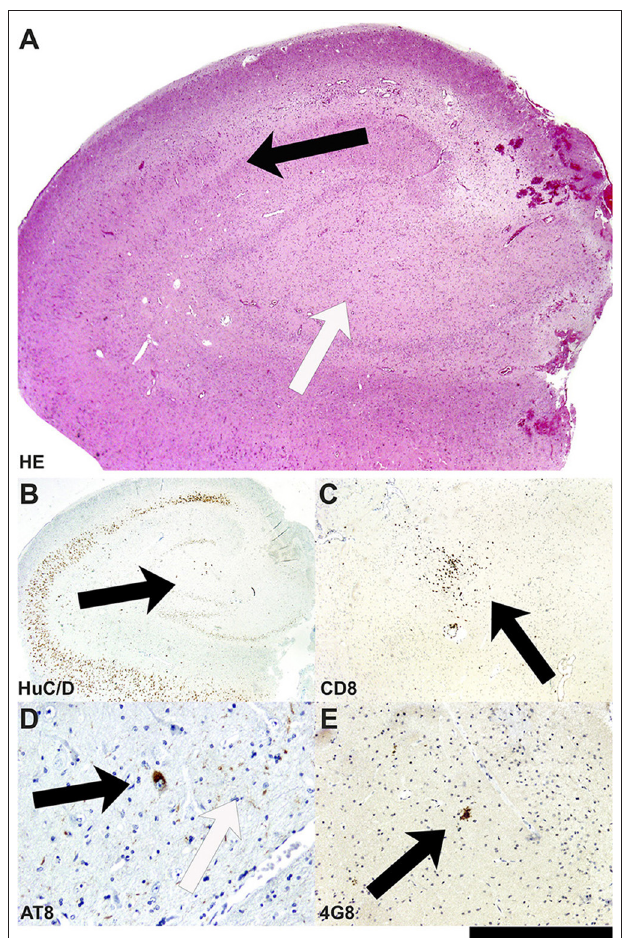
FIGURE 2 | Neuropathological findings in the hippocampal biopsy specimen in Patient #4. (A) On the HE-stained section, the hippocampal formation reveals segmental neuronal cell loss in the hilus/CA4 as well as CA3 area (white arrow), whereas the neuronal population in the CA1 area and others is rather well conserved (black arrow). (B) Segmental neuronal cell loss in hilus/CA4 is also highlighted in immunohistochemistry with antibodies against HuC/D (black arrow). (C) In the hilus/CA4 region, clusters of CD8-positive cytotoxic lymphocytes are present (black arrow). (D) Surprisingly, not only extracellular AT-8 positive tau fibrils (white arrow) but also intracellular tangle-like tau structures can be seen in neurons of this hippocampal formation (black arrow). (E) In parallel, 4G8-positive amyloid-plaque structures represent parallel extracellular deposits (black arrow; bar graph corresponds to 1.0mm in A, 2.0mm in B, 0.5mm in C; 100 µ m in D, 200 µ m in E).